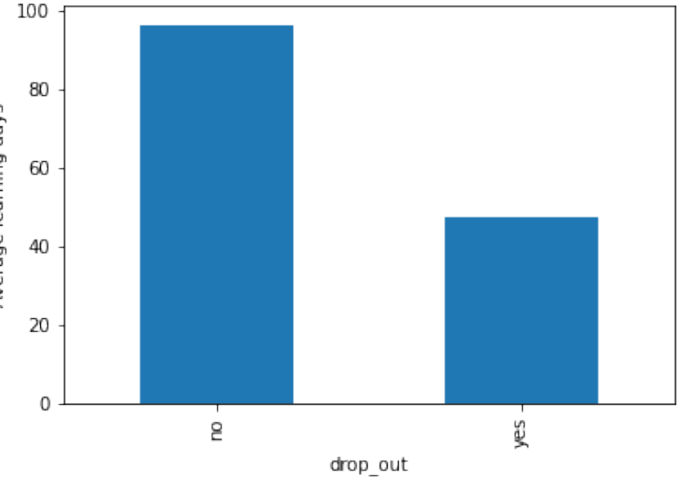
Figure 10. Comparison of average learning days between dropout students and students who normally complete their